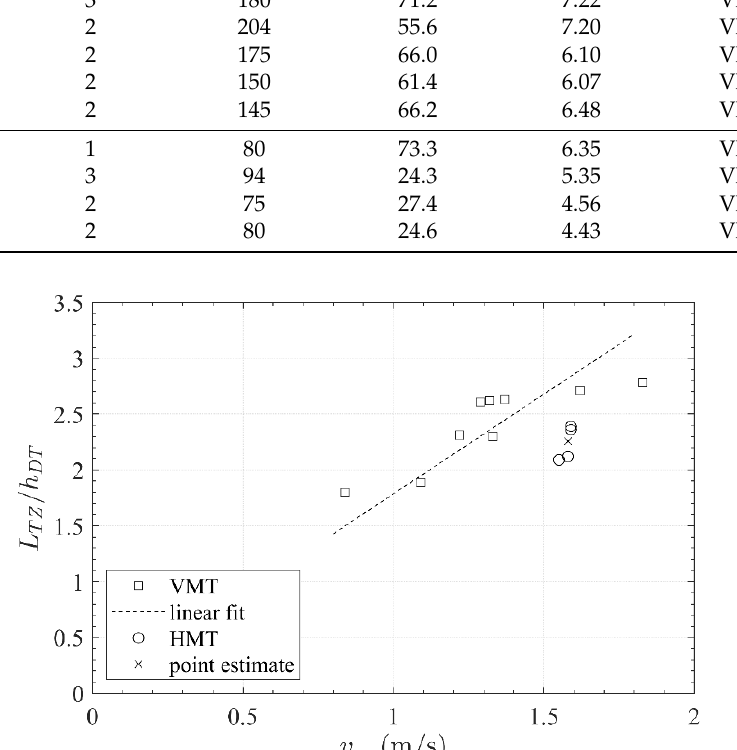
Figure 4. Normalized length of turbulent zone L TZ / h DT , as recorded from site inspections, for various bulk velocities v m at the draft tube exit section for horizontally mounted turbines (HMT) and vertically mounted turbines (VMT). Linear fit from Equation (2) with v vertical = 0.56 m/s for VMT and point estimate at v m = 1.58 m/s with v vertical = 0.7 m/s for